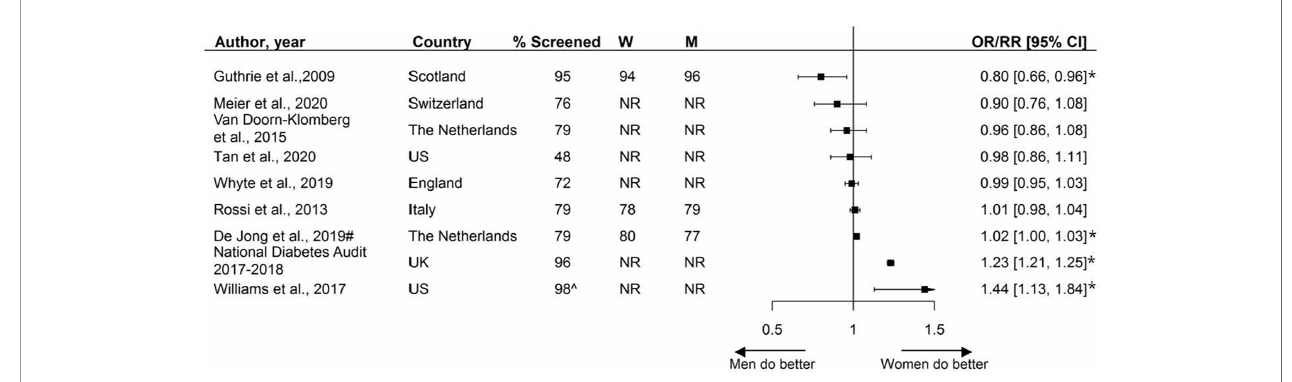
FIGURE 3 | Assessment of blood pressure, expressed as adjusted odds ratios (OR) or relative risks (RR) with corresponding 95% con fi dence intervals (CI). W = % of screened women; M = % of screened men; US, United States; UK, United Kingdom; # = Relative risk; ^ Assumed to be weighted %; * = statistically signi fi cant. Men =